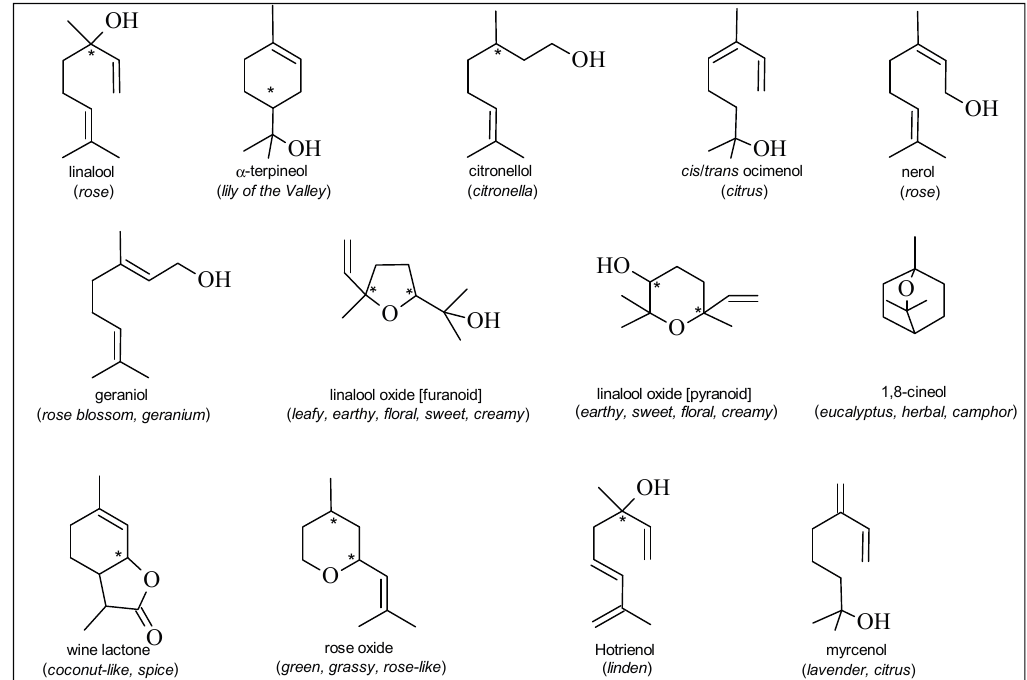
Figure 1. Principal monoterpenes identified in grapes. In brackets, the odor descriptor is reported [24].